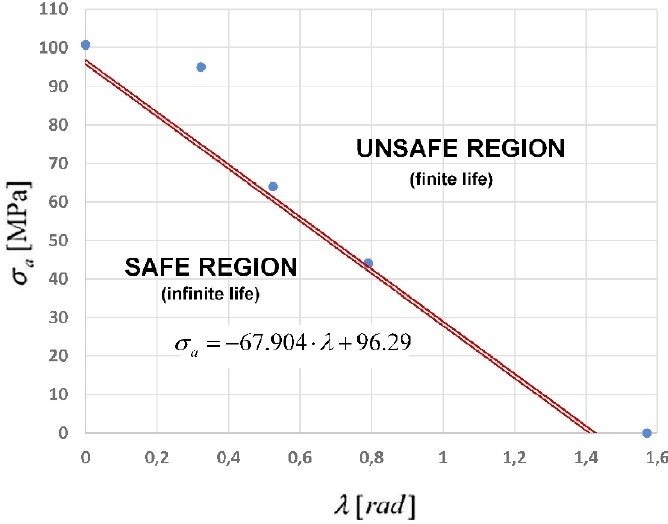
Figure 10. AZ31B-F safe region identification for proportional loading conditions.